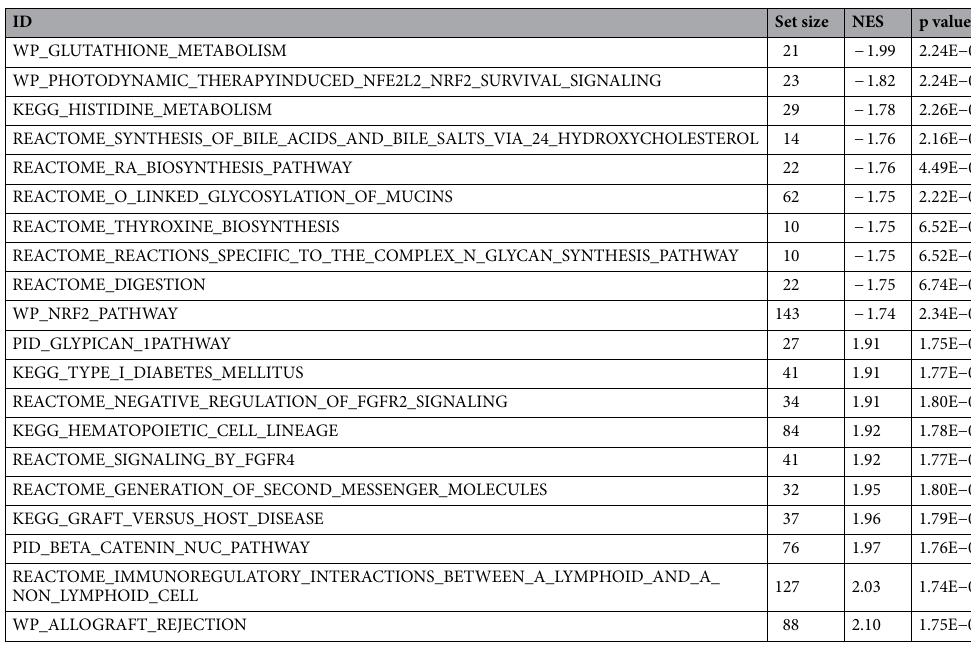
Table 4. Results of the GSEA